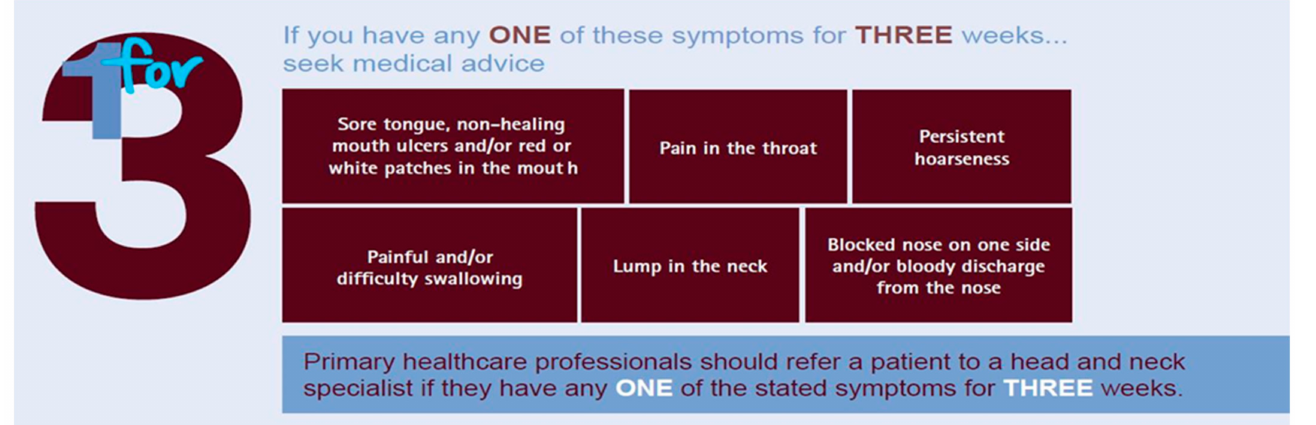
Figure 3. Awareness campaign example of ECPC. Head and neck cancer is a preventable and curable cancer, yet it continues to kill half of all sufferers. Awareness of the disease is alarmingly low; 73% of the general population in a 2020 pan-European survey were unaware of the disease’s symptoms. Early diagnosis and referral save lives. Therefore, there is an urgent need, not only to raise awareness of the signs and symptoms of the disease, but also to educate the general public and healthcare providers on the importance of prevention and regular